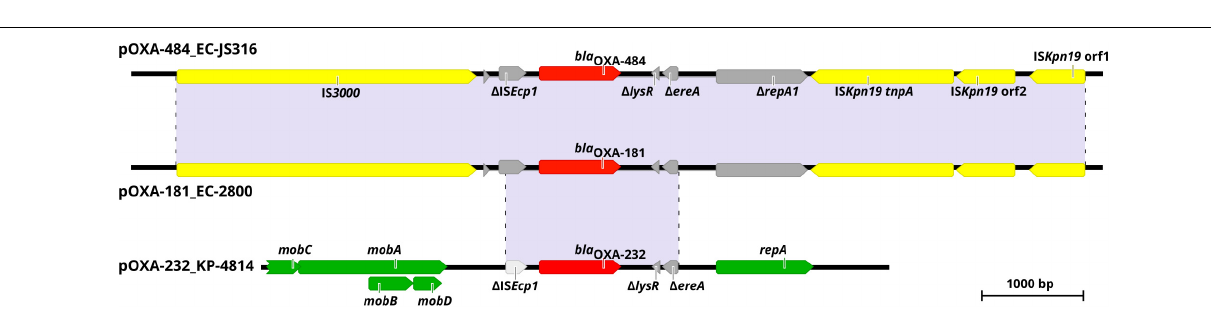
FIGURE 1 | Plasmid map of pOXA-484 harboring bla OXA - 484 . Colored arrows indicate antibiotic resistance genes bla OXA - 484 (dark red) and qnr S1 (light red), insertion elements (yellow), disrupted genes (gray), replication, partitioning, plasmid stabilization, and transfer genes of the IncX3 plasmid backbone (green) and hypothetical proteins (light blue). The IncX3 plasmid backbone is marked in purple. GC content is represented by the inner green line and AT content by the inner blue line.